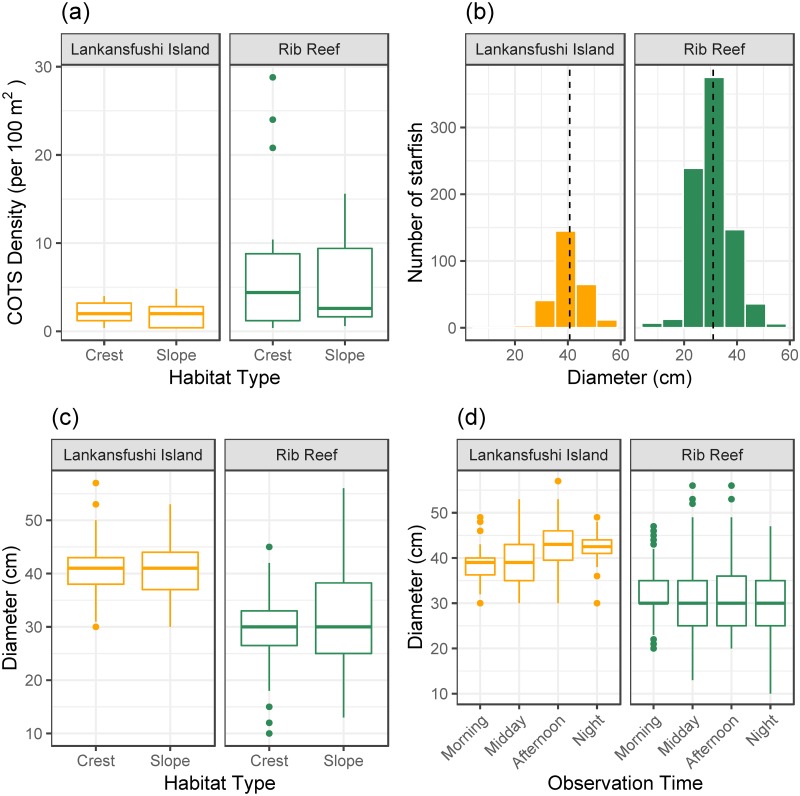
Comparisons between Lankanfushi Island and Rib Reef.A) Boxplot of CoTS per 100m2 between habitat types. B) Frequency histogram of diameter of observed individuals. The mean is represented by the dotted line. C) Boxplot of diameter of observed individuals between habitats. D) Boxplot of diameter of observed individuals among observation time categories.